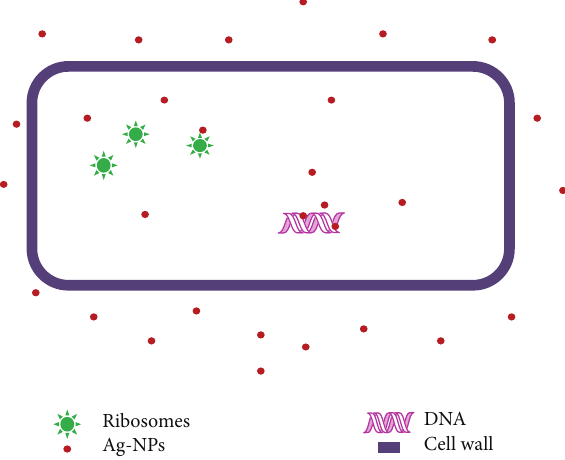
Figure 4: Schematic of antibacterial activity of Ag-NPs. Ag-NPs get adhered to the cell wall of bacterial cell through sulphur present in the protein comprising the bacterial cell wall, ultimately causing bacterial cell death. Ag-NPs also hamper protein synthesis along with directly causing damage to the interior of the bacterial cell by directly penetrating the cell wall and cell